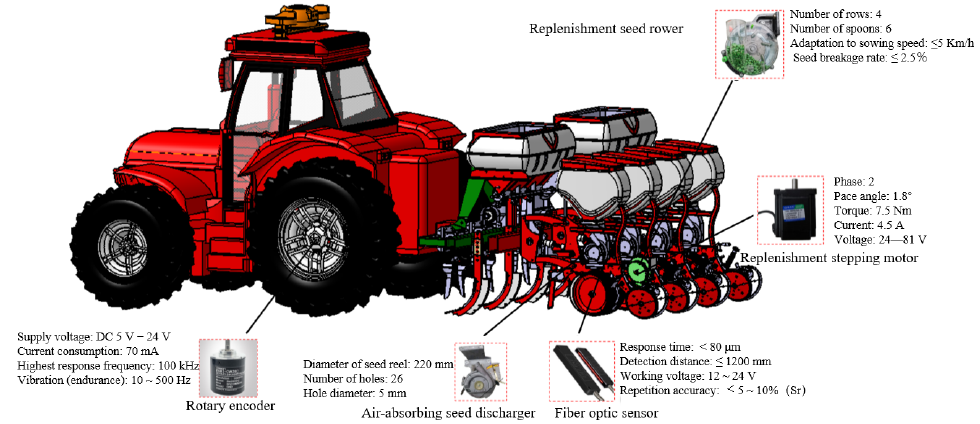
Figure 2. Structure diagram of loss sowing detection and reseeding system of precision sowing for corn.